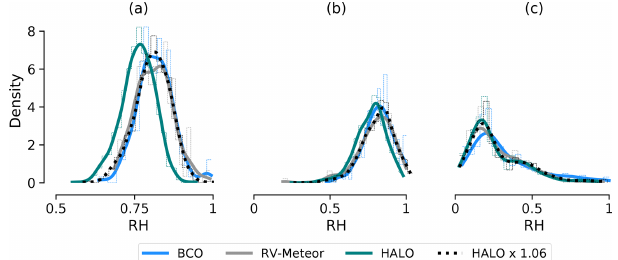
Figure 5. Spread (kernel density estimates) in relative humidity val- ues from soundings made by BCO, Meteor and HALO at a (a) mean of 0–500m, (b) mean of 750–1500m and (c) mean of 2000–4000m. The last item in the legend is for RH values of HALO multiplied by 1.06. To coincide with HALO measurement times, BCO and Me- teor soundings between 03:00 and 09:00UTC have been excluded from these distributions, which has a relatively insignificant